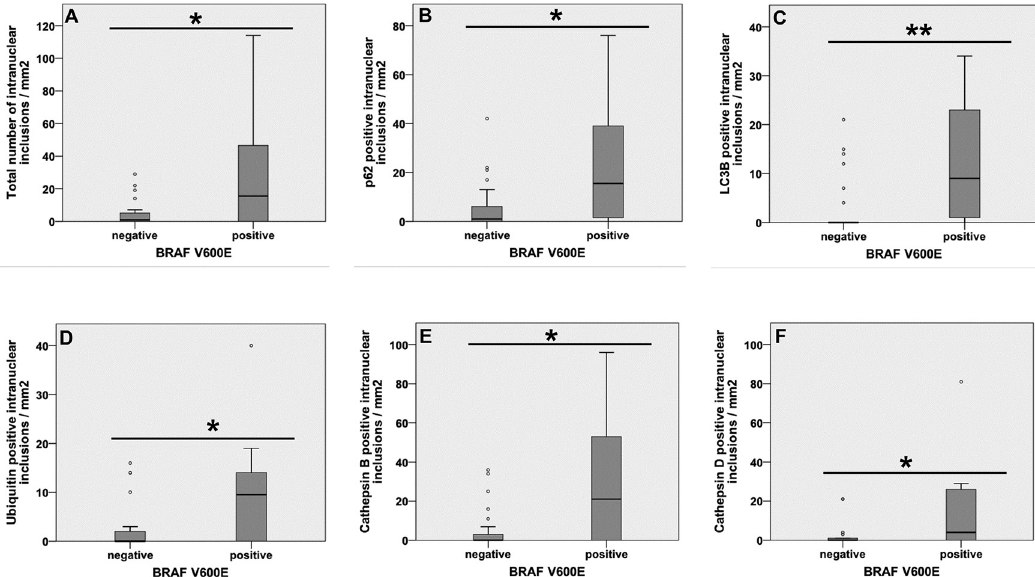
Fig 6. Associations between BRAF mutational status and NI in PTCs. (A) The diagram depicts a significant association between BRAF mutational status and the number of NI/case with p = 0.042. (B-F) Significant correlation between BRAF mutational status and immunoreactivity for autophagy-associated proteins in NI is shown. (B) p62 positive NI/case vs. BRAF V600E : p = 0.024, (C) LC3B positive NI/case vs. BRAF V600E : p = 0.003, (D) Ubiquitin positive NI/case vs. BRAF V600E : p = 0.032, (E) Cathepsin B positive NI/case vs. BRAF V600E : p = 0.035 and (F) Cathepsin D positive NI/case vs. BRAF V600E : p = 0.013. Results are significant at � p � 0.05, �� p � 0.01, and ��� p �